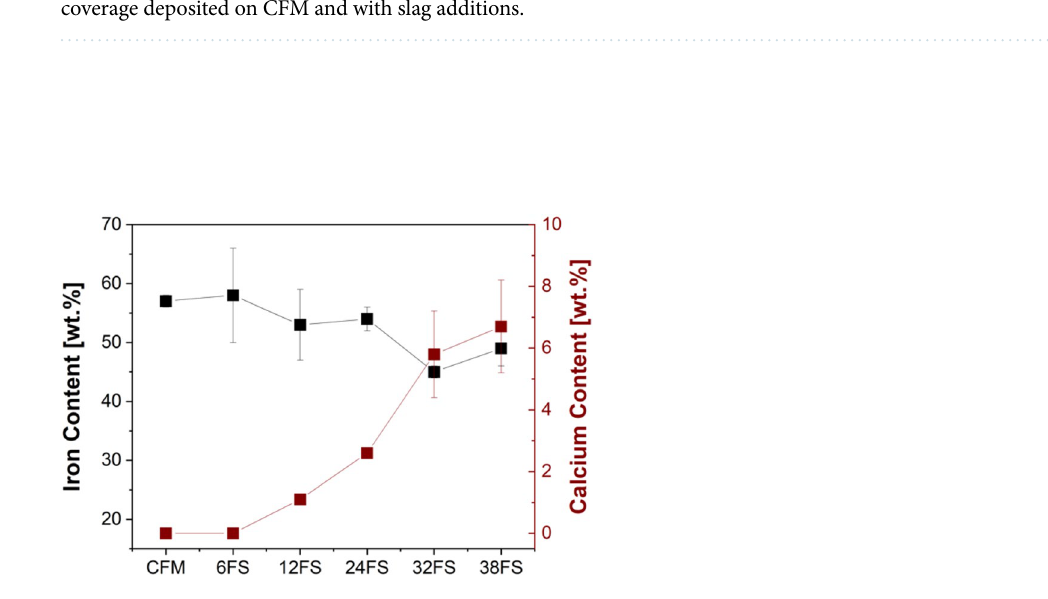
Figure 6. Fe and Ca variation with the increase in the slag content in